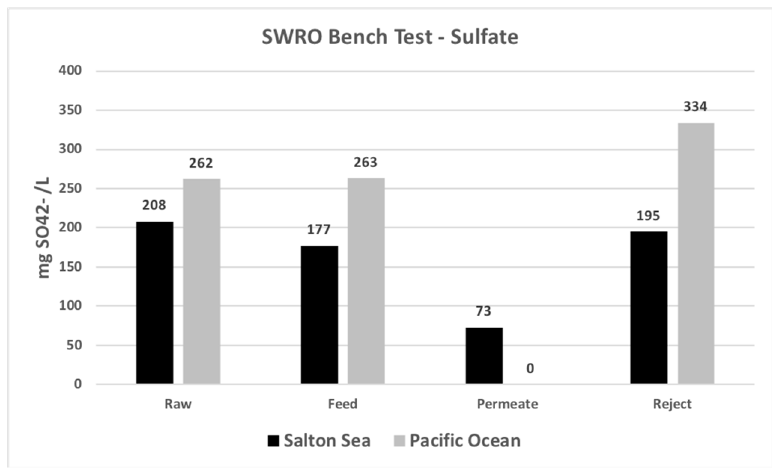
Figure 12. Sulfate of raw water, SWRO feed, permeate, and reject flow.